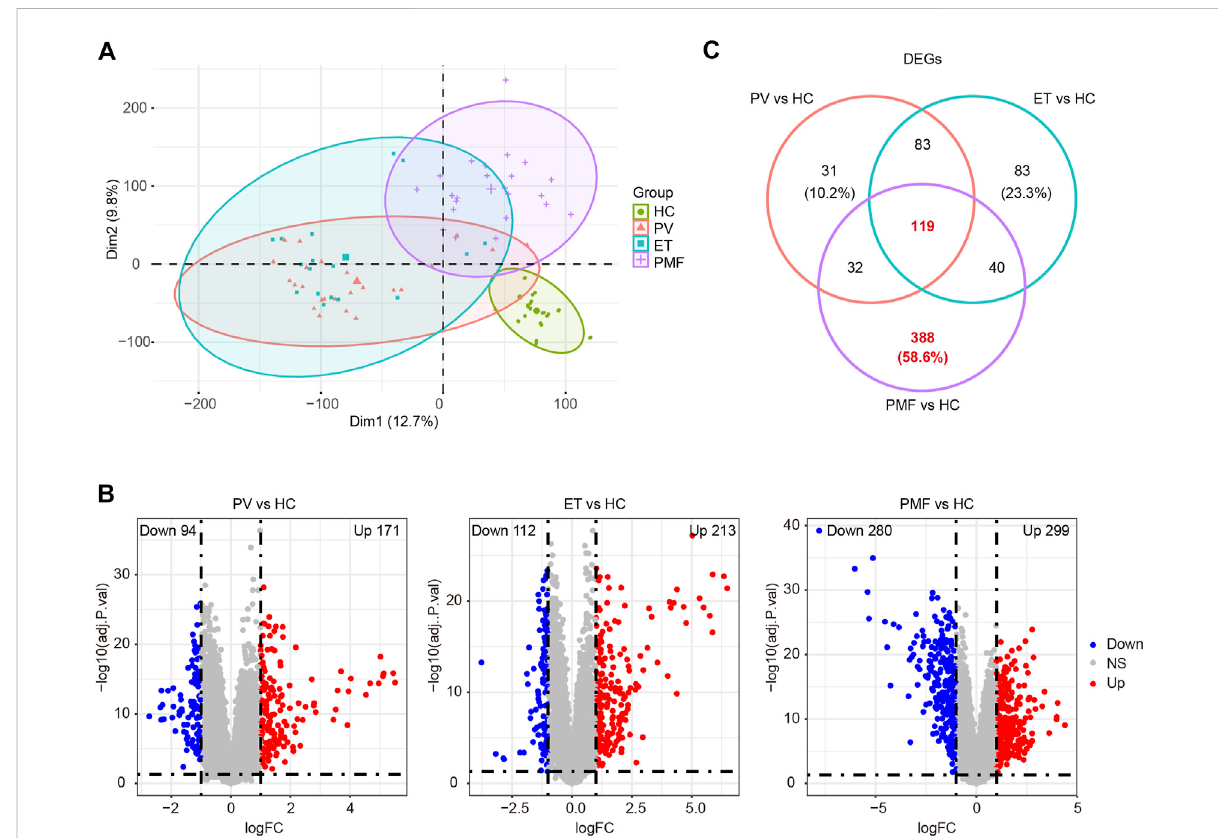
FIGURE 1 (A) PCAdiagram after removingbatch effect. (B) Volcano plots ofDEGs between eachMPN subtype andhealthy controls (HC).The numbers of upregulated genes and downregulated genes wereshown. The red dots represent upregulated genes.The bluedots indicate downregulated genes. The gray dots denote genes with non-differential expression. (C) Venn diagram of DEGs between each MPN subtype and